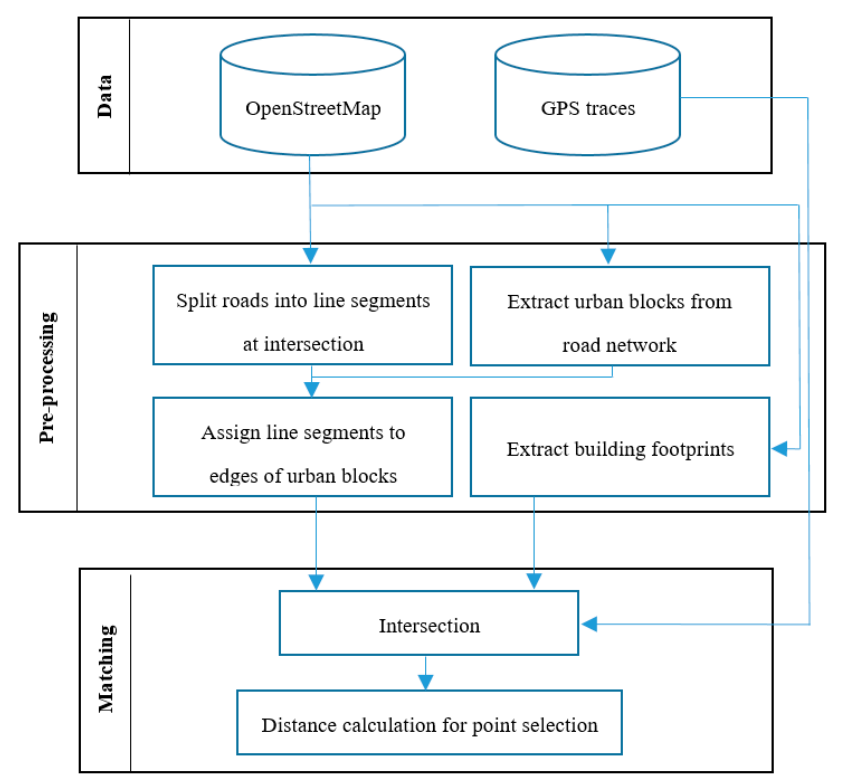
Figure 7. Workflow for matching and comparison of OpenStreetMap and GPS dataset.